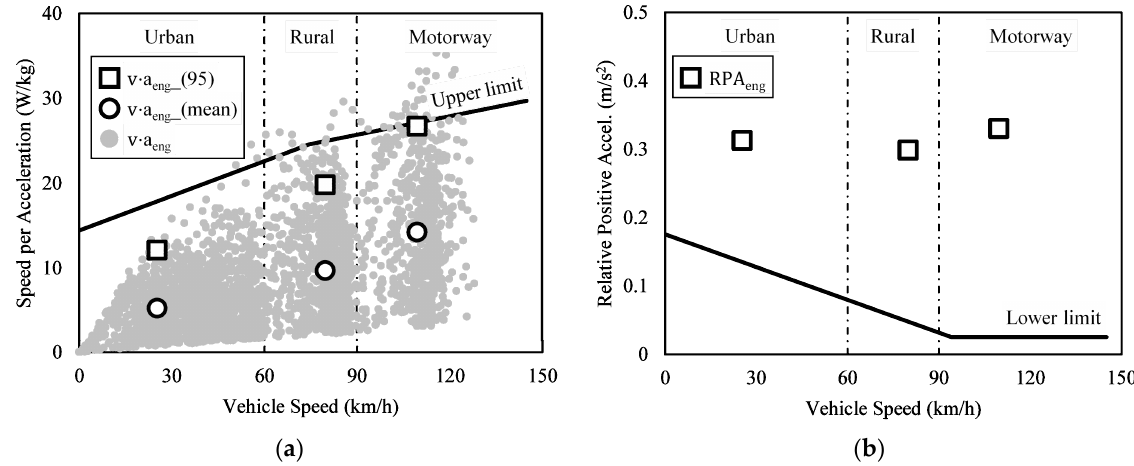
Figure 6. Verification of driving dynamics for the new analysis method. ( a ) Speed per acceleration vs. vehicle speed. ( b ) Relative positive acceleration vs. vehicle speed.